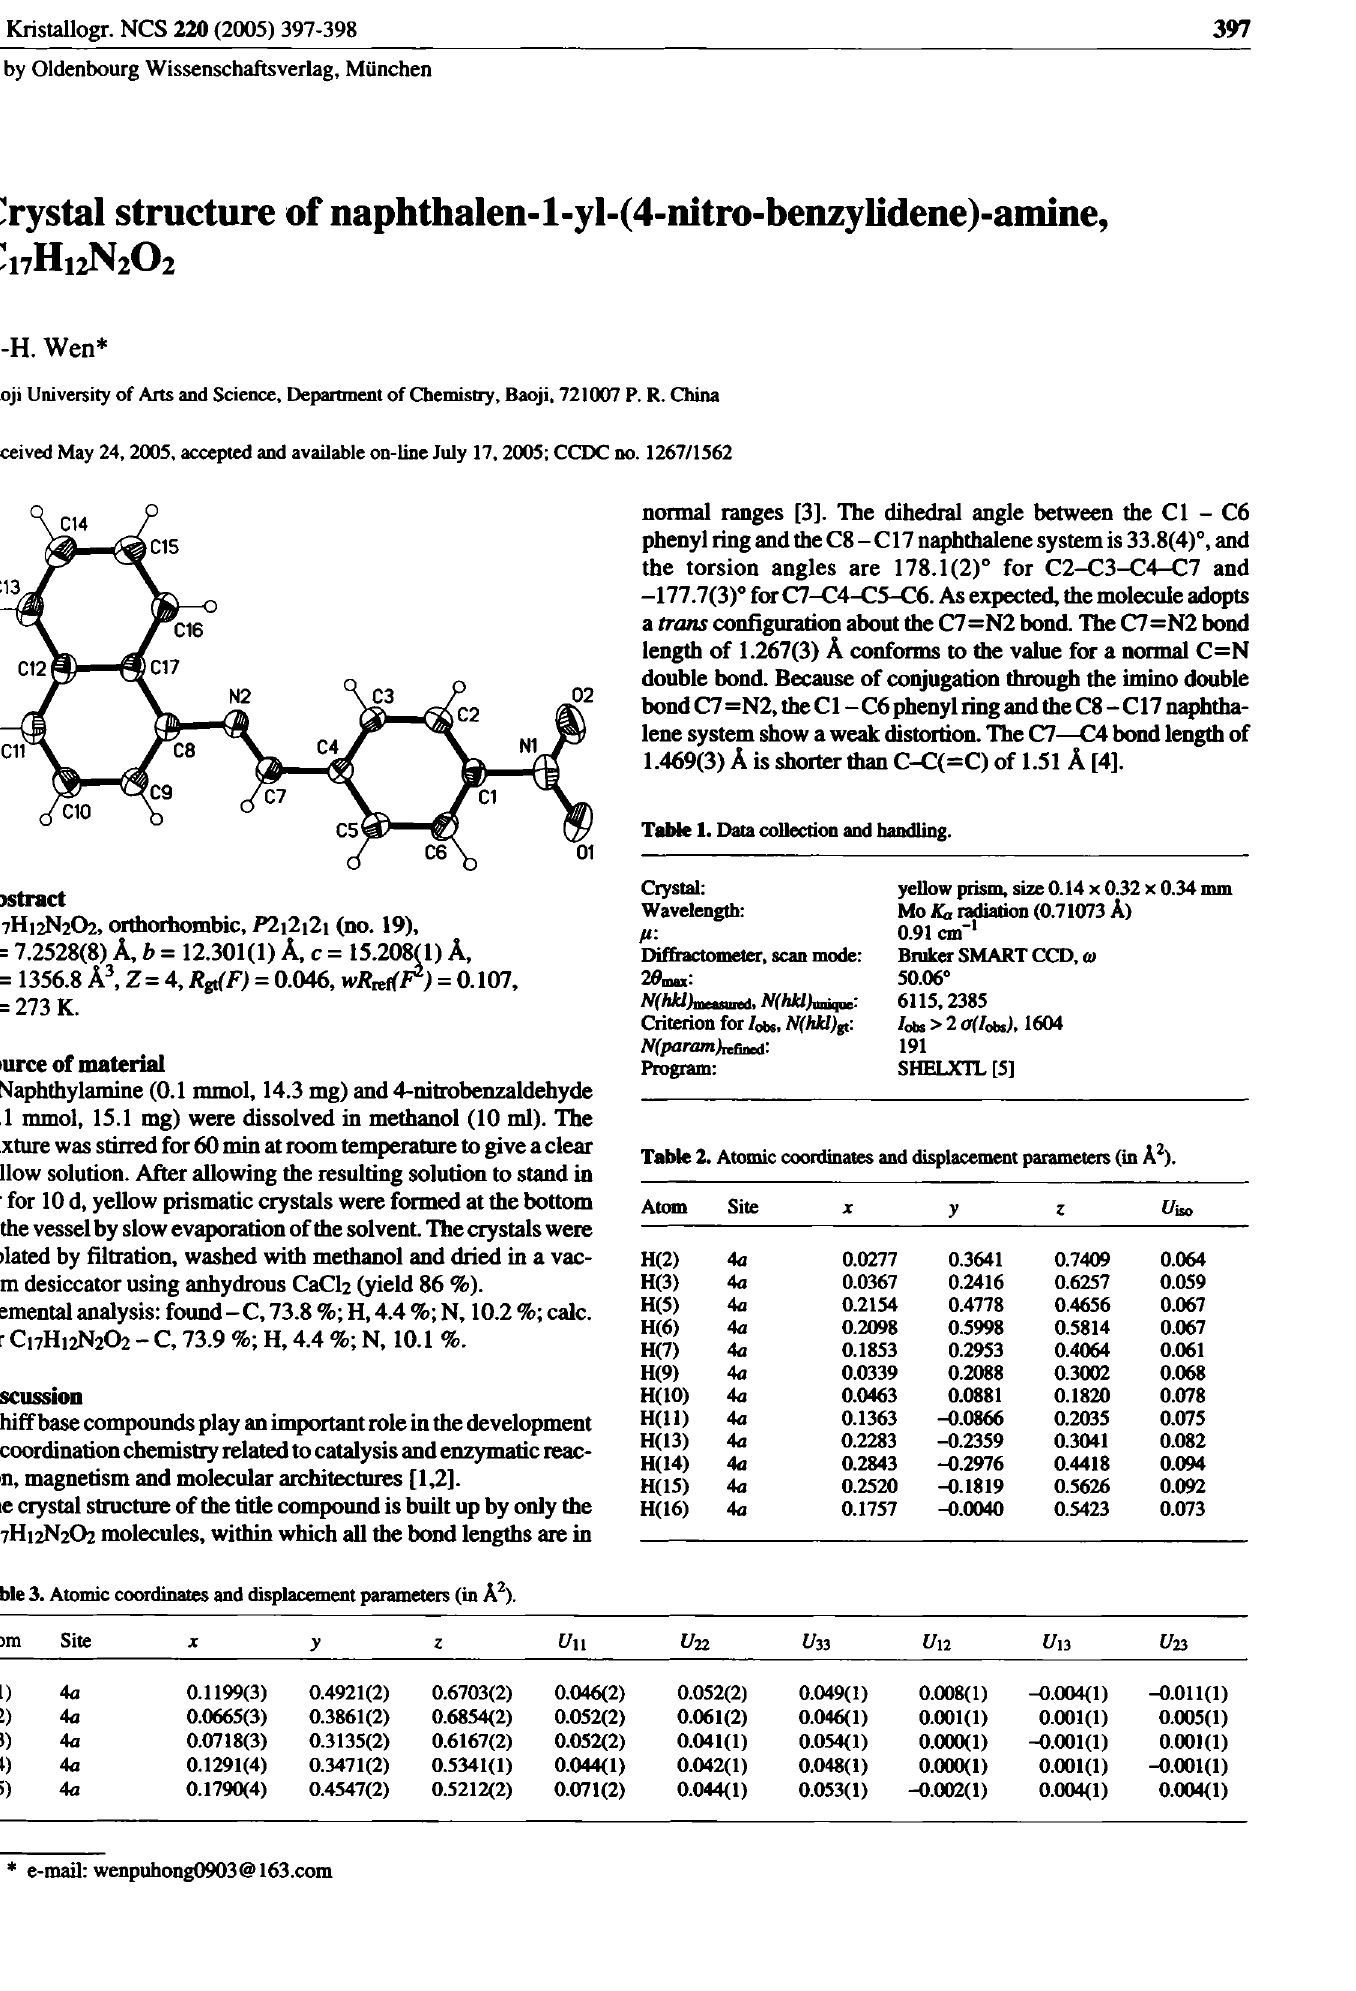
Table 3. Atomic coordinates and displacement parameters (in A 2 ).